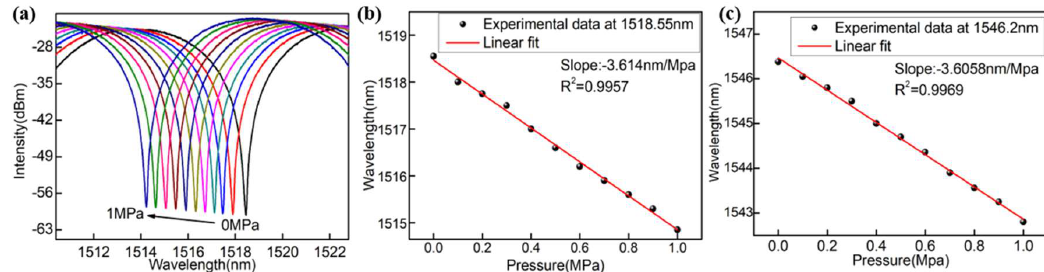
Figure 5. ( a ) Response of the micro-bubble sensor to pressure; resonant wavelengths of the interference fringe versus different gas pressures for the sensor at ( b ) 1518.55 nm and ( c ) 1546.2 nm.